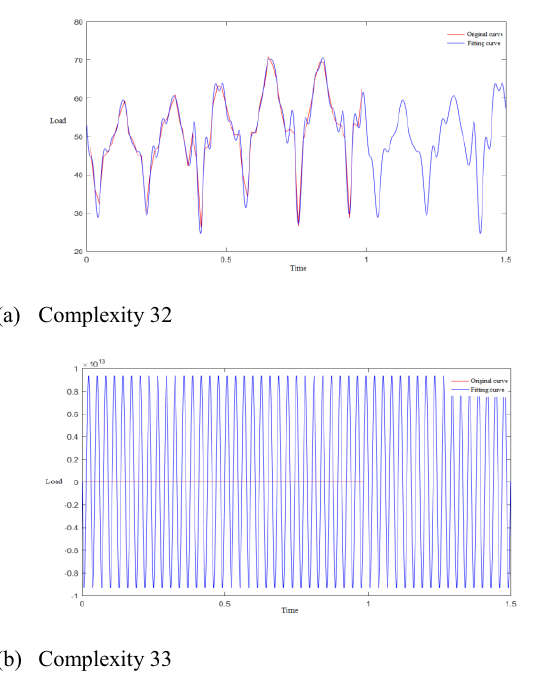
Figure 5. The best fitting effect diagram and the over fitting effect